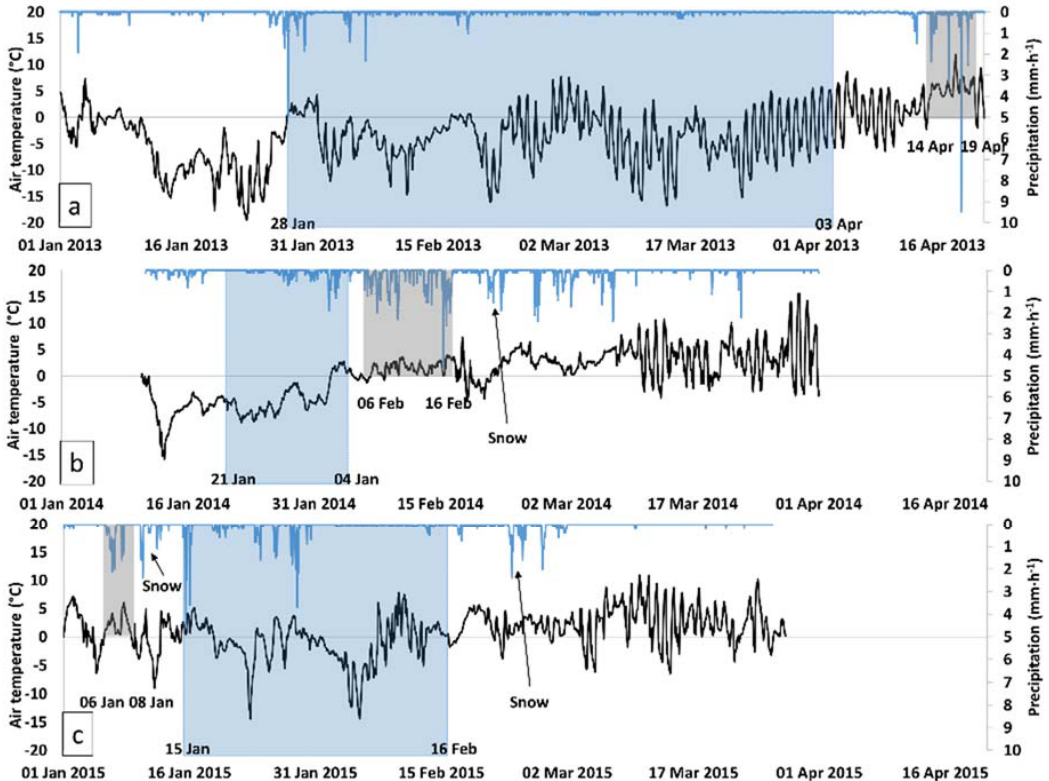
Figure 2. Measured air temperature and precipitation for the three winter periods: 2013 ( a ); 2014 ( b ); and 2015 ( c ). Rain events of interest for this study with start and end dates are marked with grey bands. The duration of unbroken snow cover with start and end dates is indicated with blue bands. Snow events outside the unbroken snow cover period are marked as ‘snow’.